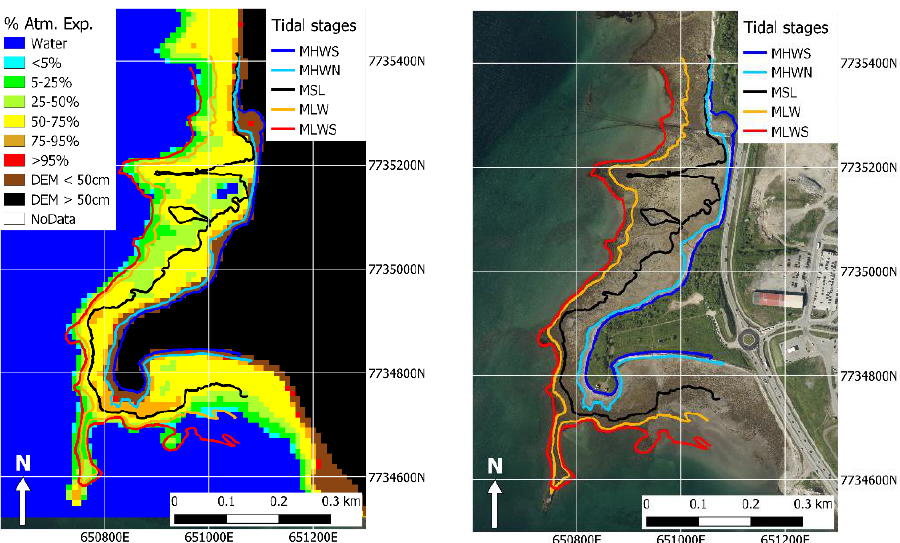
Figure 13. Different tidal water level lines superimposed on the ( left ) ITZ atmospheric exposure product and ( right ) aerial mosaic (© norgeibilder.no, Kartverket, Norge digitalt, Terratec AS/Blom Norway AS) at Langnes, Tromsø, Troms.